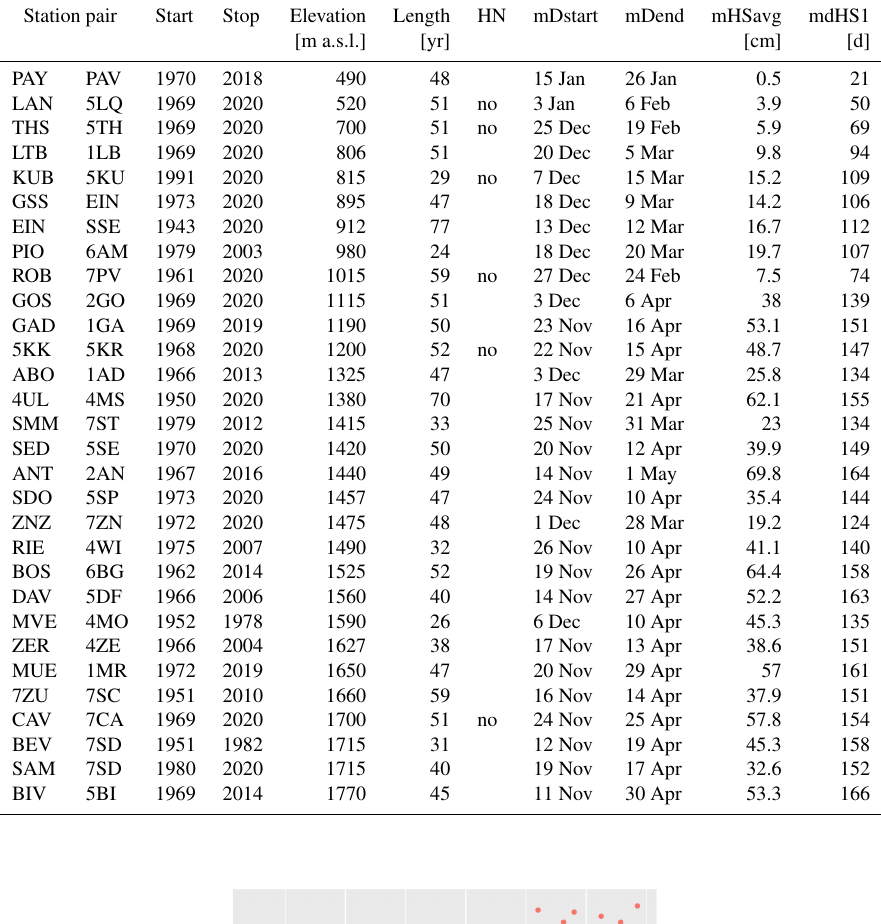
Table A1. Station pairs, available parallel periods, mean elevation, and number of parallel years. HN indicates whether a station pair was used for HN analyses. mDstart and mDend are mean onset and disappearance dates, mHSavg indicates the mean average snow depth, and mdHS1 indicates the mean number of days with snow on the ground. Station indicators starting with a number refer to SLF stations, and station indicators without a number refer to MeteoSwiss stations.